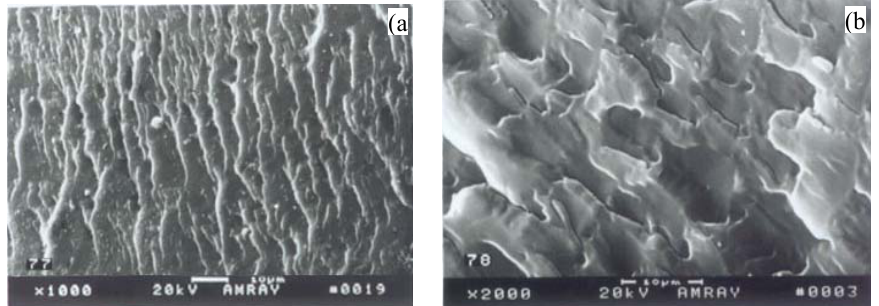
Figure 4. SEM micrographs of the P(MAA-co-MMA) network before and after complexation with PVP: (a) the network without complexation; (b) the P(MAA-co- MMA)/PVP complex formed in the solution of PVP with